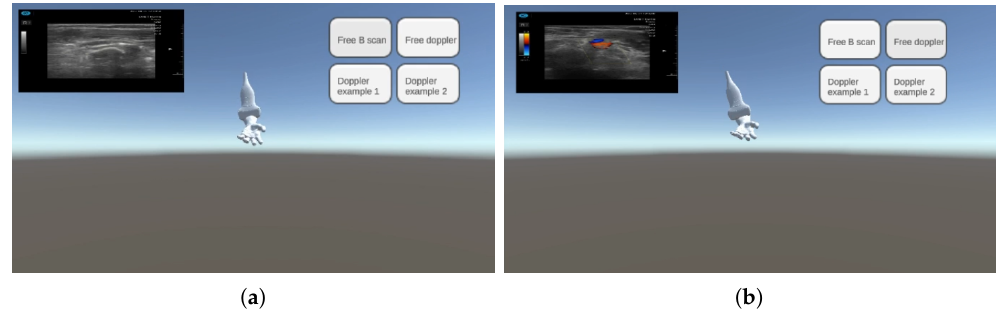
Figure 4. Screenshot of the Current System when training in B-Mode ( a ) and in Doppler mode ( b